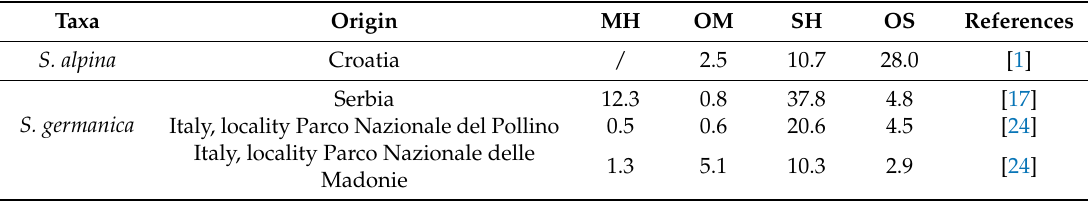
Table 1. Main component groups found in Stachys taxa essential oil from aerial parts (monoterpene hydrocarbons: MH; oxygenated monoterpenes: OM; sesquiterpene hydrocarbons: SH; oxygenated sesquiterpenes: